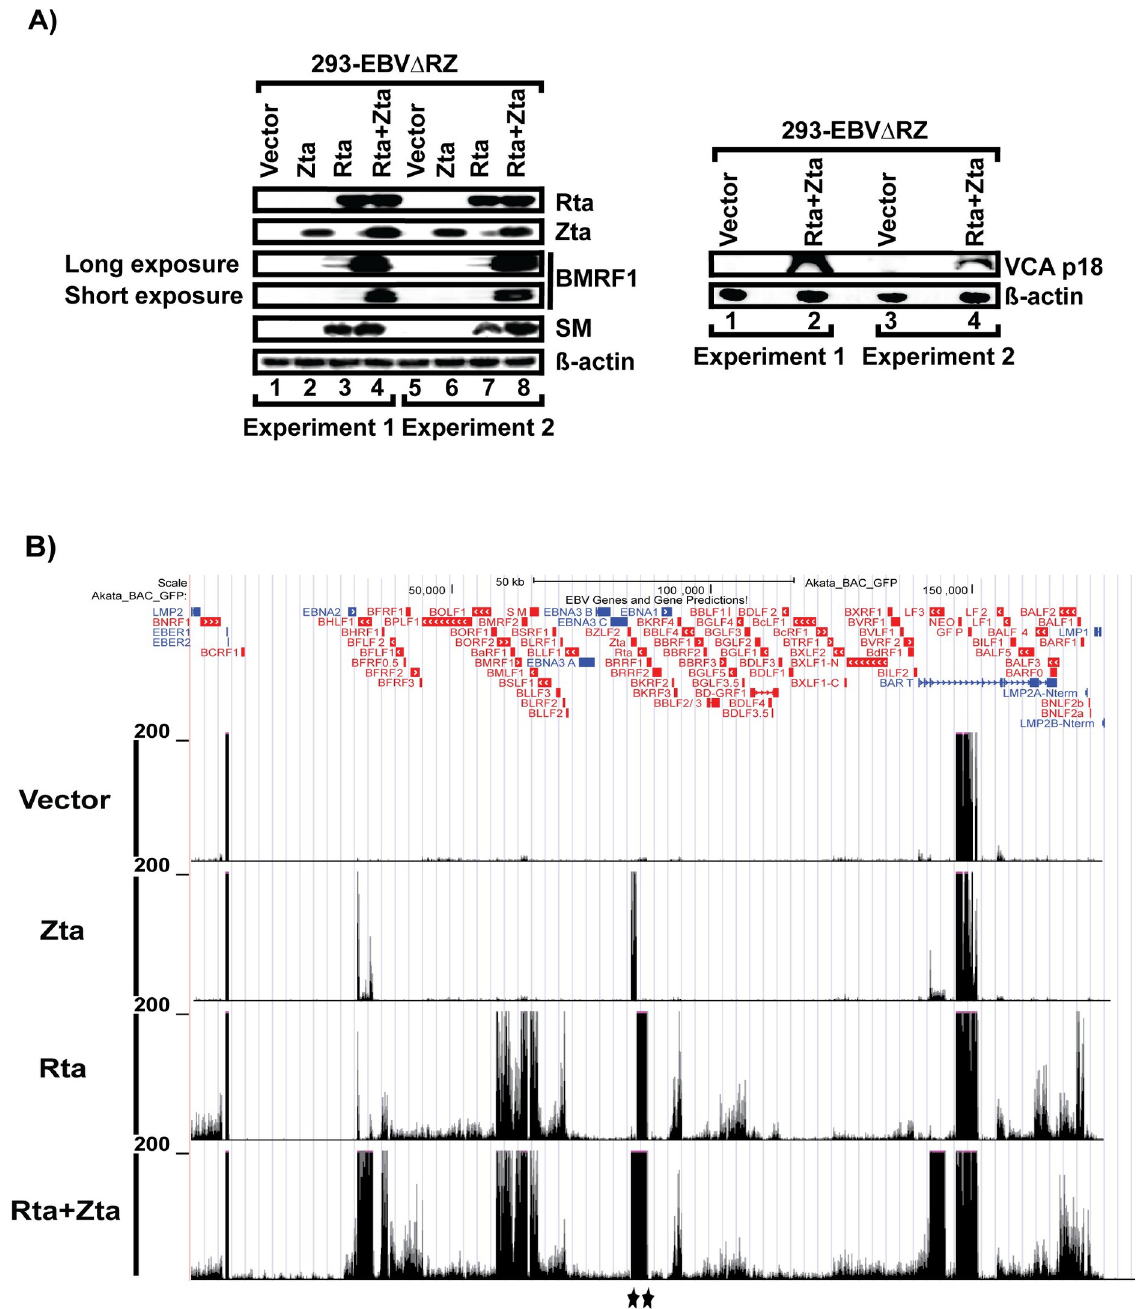
Fig 2. Rta and Zta dependence of EBV lytic gene expression in 293 cells. (A) Western blots showing the specified EBV or cell proteins from 293-EBV Δ RZ cells transfected with vector only, Zta, Rta, or both (Rta+Zta). Data are two independent experiments from the same 293-EBV Δ RZ clone. (B) UCSC genome browser images displaying RNA-seq data mapped to the EBV Akata_BAC_GFP genome. Each track corresponds to complementation with Rta and/or Zta as indicated on the left as described for (A). Black stars indicate reads arising from transfected Rta and/or Zta (i.e., not expressed from the EBV genome).